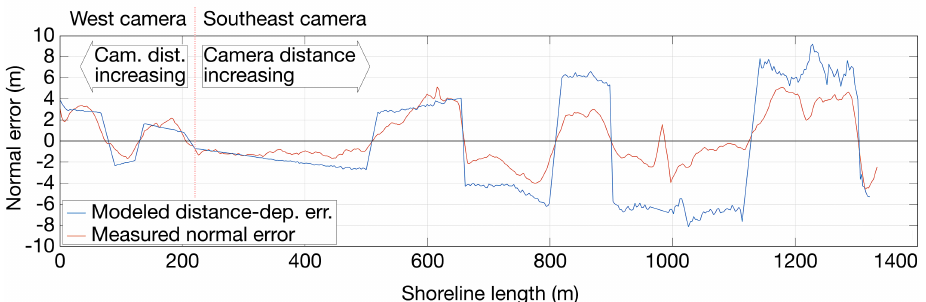
Figure 12. Distance-dependent part of the normal